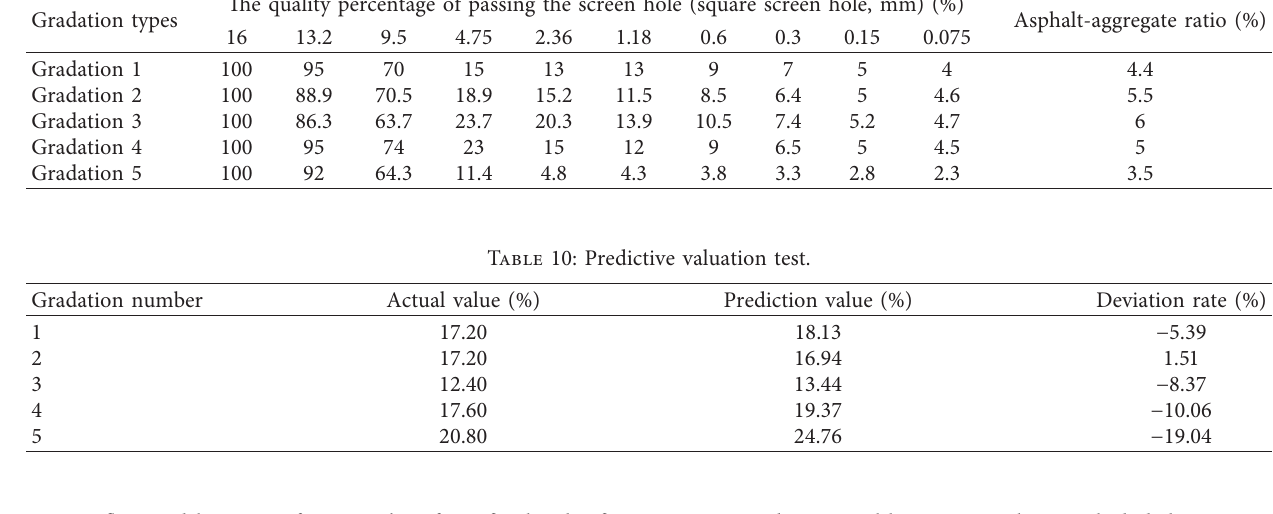
Table 8: F : Fa � 0.05 (5,18) � 2.77. Since 37.099 is bigger than 2.77, it was concluded that VMA, P closely connected with the connected voids ratio.